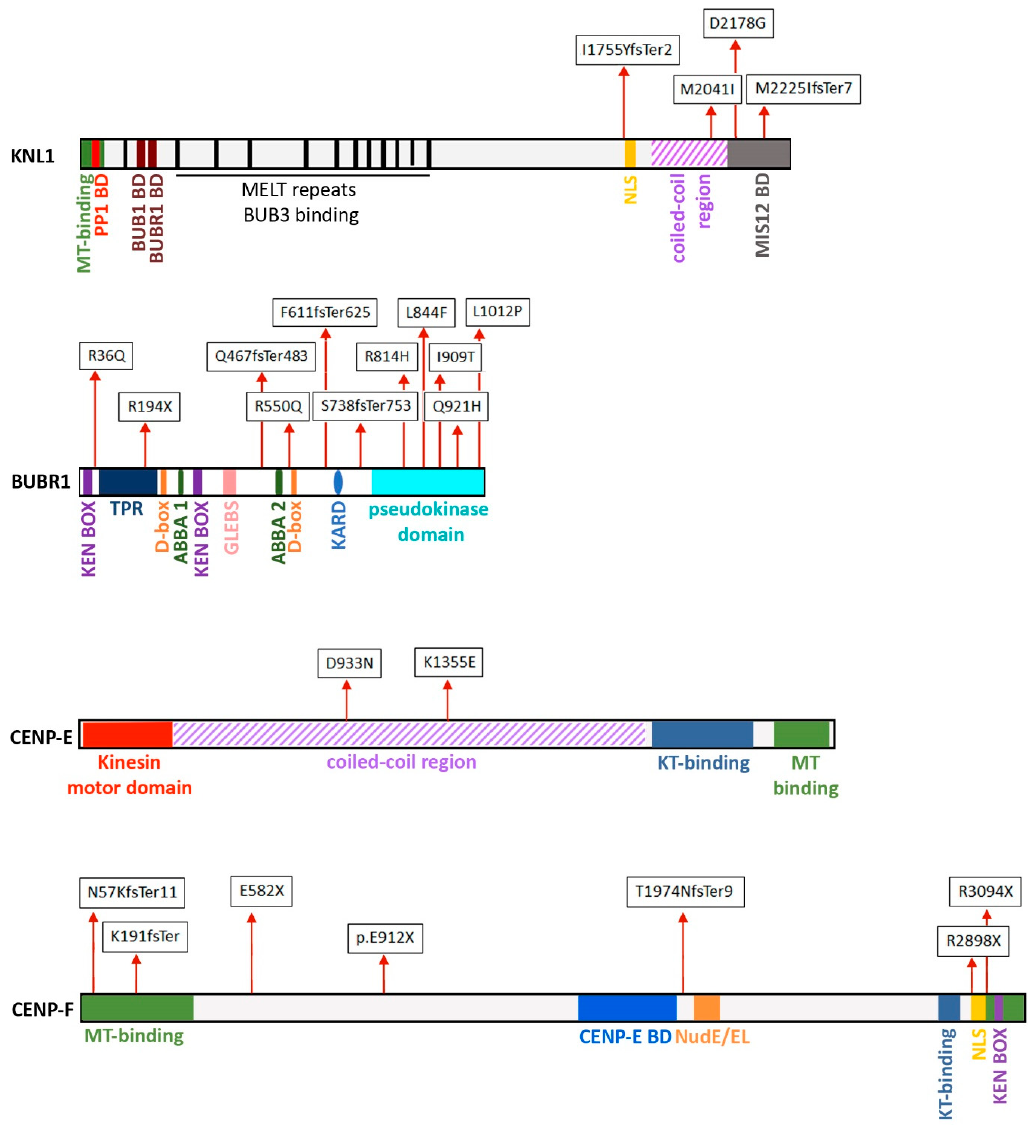
Figure 1. The maps depict relevant domains in kinetochore proteins associated with microcephaly when mutated. The sites of aminoacidic substitutions caused by microcephaly-associated mutations are boxed.